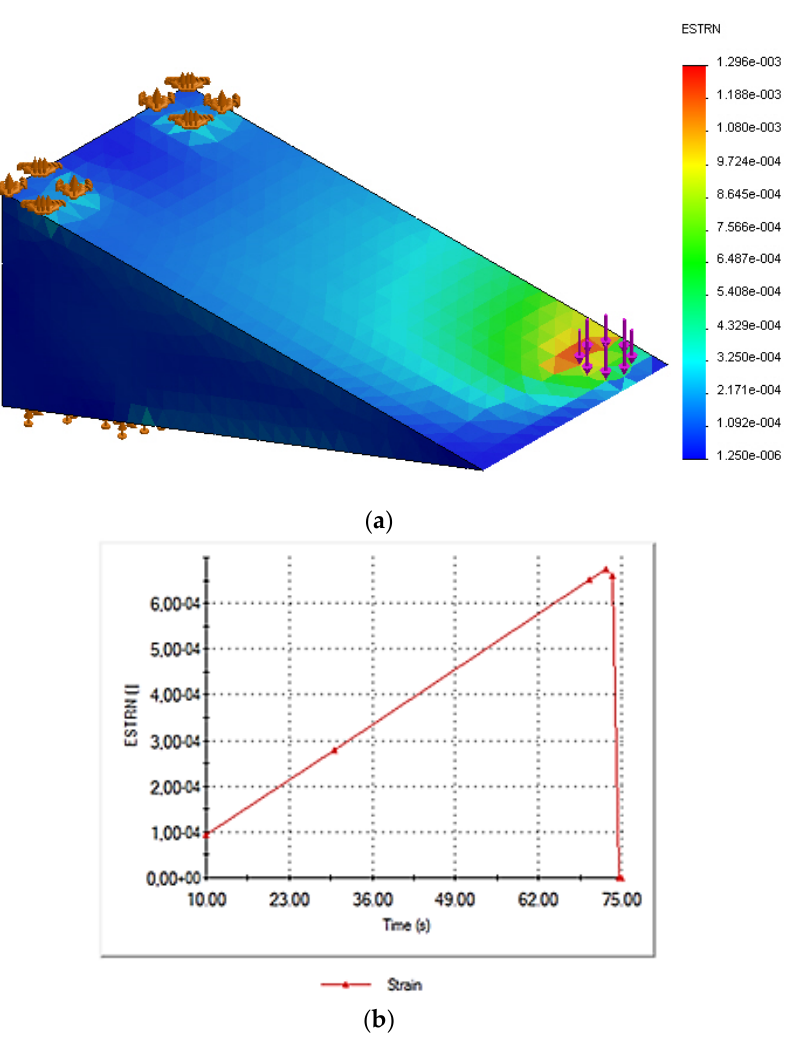
Figure 8. ( a ) Three-dimensional (3D) model highlighting equivalent strain; ( b ) equivalent strain vs. time for the model without the cut.